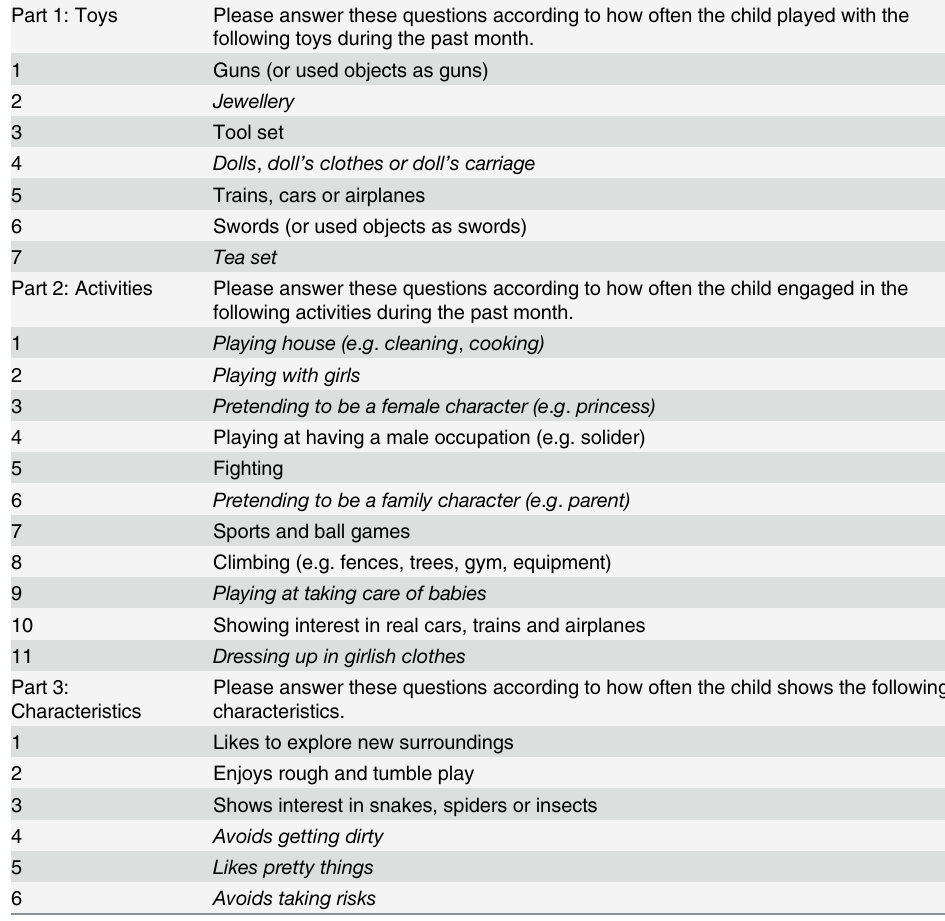
Table 1. Preschool Activities Inventory